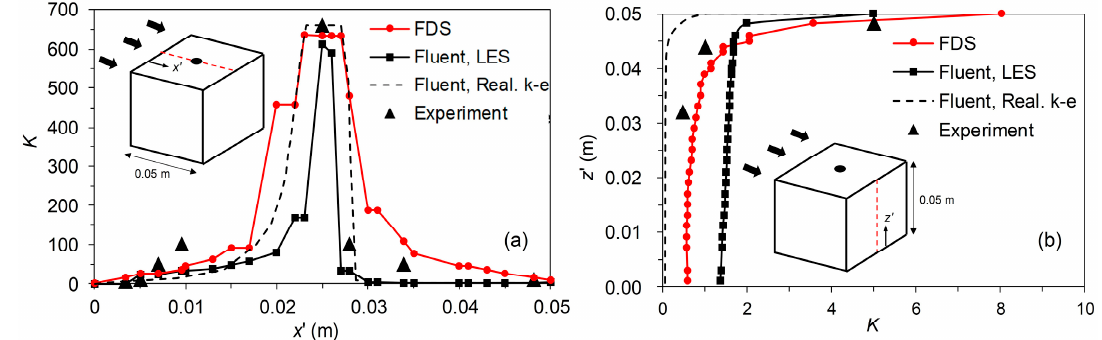
Figure 10. Experimental and numerical results of the pollutant concentration on the ( a ) rooftop and ( b ) leeward surface.